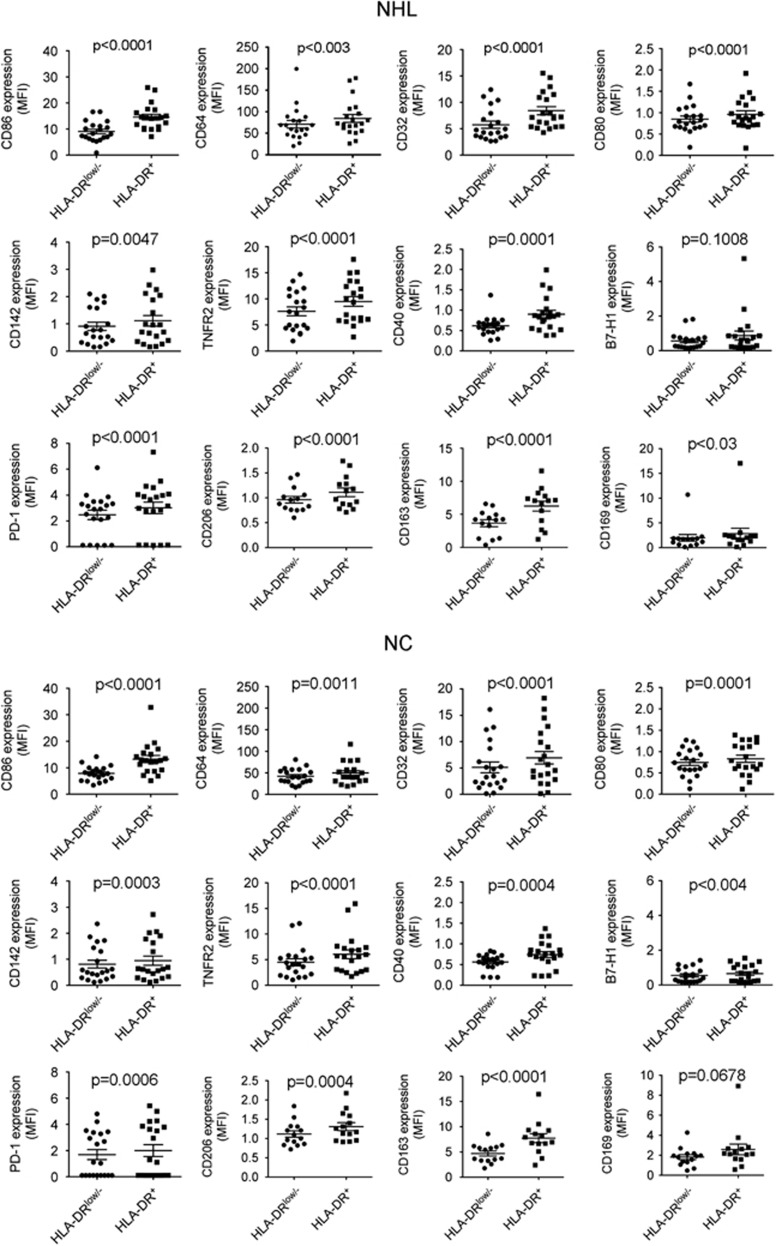
Phenotype of CD14+HLA-DRlow/− or HLA-DR+ monocytes in B-cell NHL. A 10-color flow cytometry was employed to determine the expression of surface markers included CD86, CD64, CD32, CD80, CD142, TNFR2, CD40, B7-H1, PD-1, CD206, CD163 and CD169 on CD14+HLA-DRlow/− or CD14+HLA-DR+ monocytes from both healthy donors (NC) or lymphoma patients (NHL).